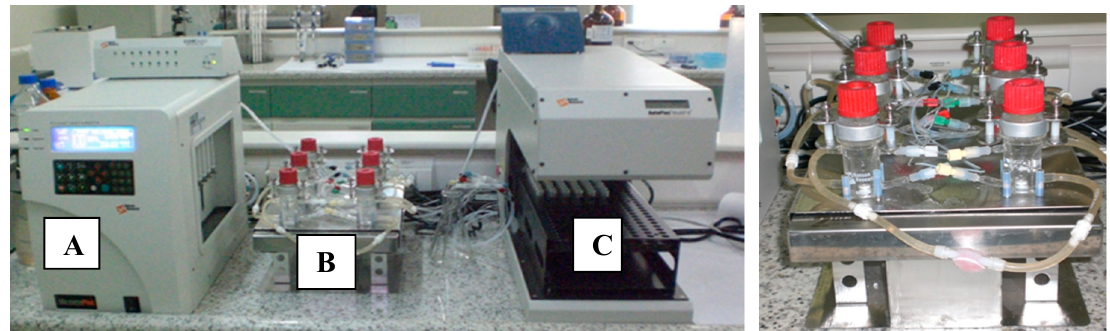
Figure 1. Franz cells apparatus (Microette™, Hanson Research) mounted with a previously validated PAMPA membrane from Corti et al. [5,16] for simulating gastrointestinal permeation. ( A ) System control for injection pistons of upper chambers; ( B ) upper and lower diffusion chambers with temperature and stirring control; ( C ) automated module for sampling and collection.